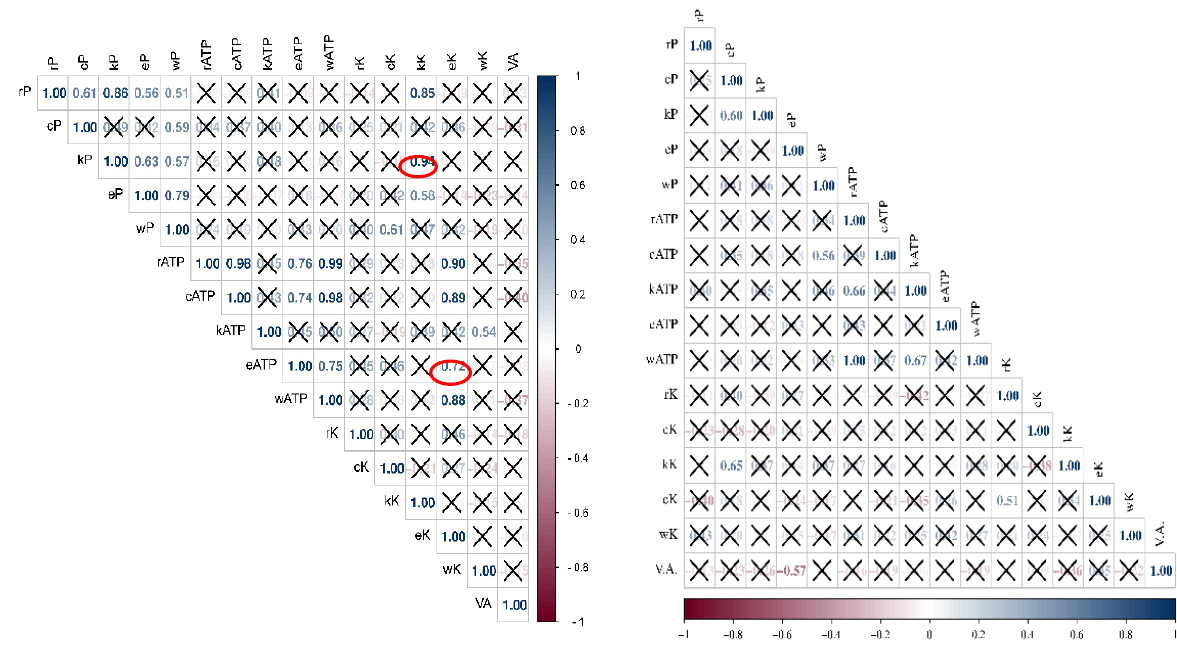
Figure 6. Heat map representing the correlation coefficient between the utilized methods for hy- giene assessment in food trucks outlets. Upper triangle − TVC; lower triangle − S . aureus ; P − Petrifilm method; ATP − adenosine 5 − triphosphate; K − reference method; VA − visual assessment method; r − re- frigerator; c − cutting board; k − knife; e − serving board; w − working board. X − label represents insig- nificant p -value .